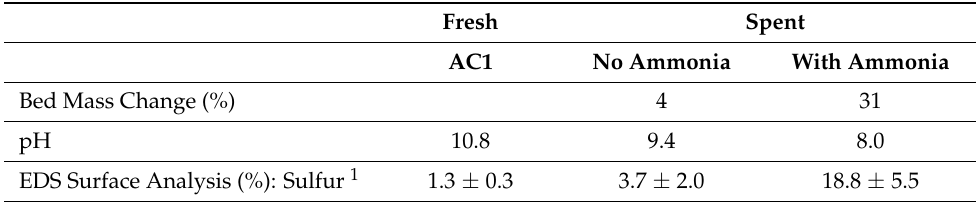
Table 5. Spent adsorbent characterization from lab-scale experiments presented in Figure 5b (SV 3700 h − 1